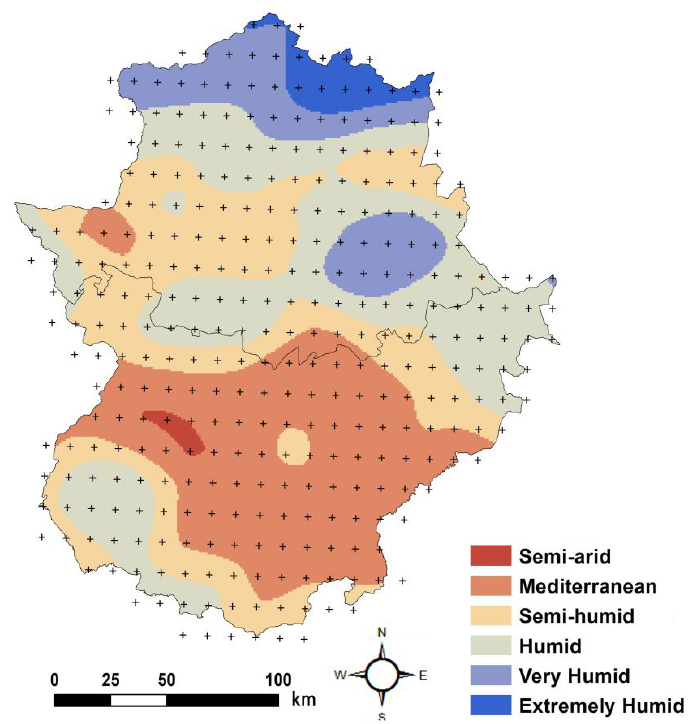
Figure 5. Spatial distribution of the De Martonne aridity index in Extremadura considering the baseline climate, 1971–2005. Grid cells for the study are also indicated. Table 5. Statistics of the Mann-Kendall test (ZMK) and the magnitude of trends approximated by Sen’s estimator ( β ) for the De Martonne aridity index (I DM ), considering the historical period and different periods (P1, 2006–2035; P2, 2036–2065; P3, 2066–2095) until the end of the 21st century for each scenario. RC is the relative